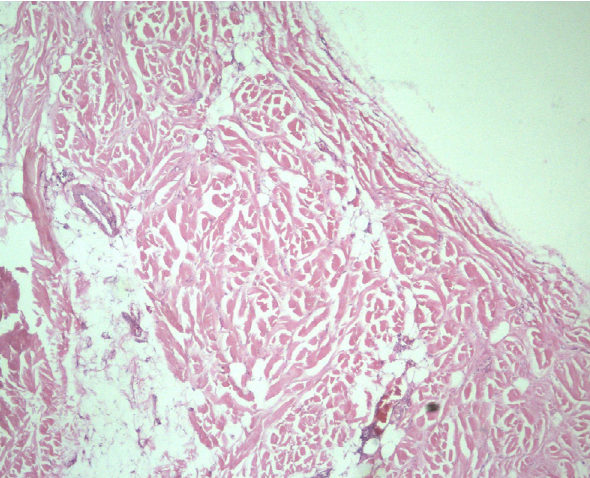
Figure 1 Microphotograph showing spindle shaped cells arranged in short fascicles, whirling and storiform